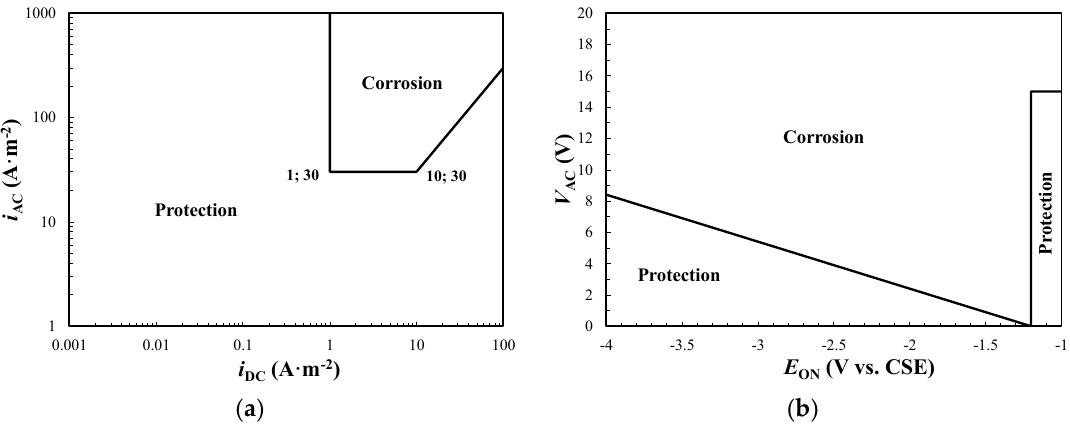
Figure 9. Graphical representation of the AC protection criteria reported on ISO 18086 [4]: ( a ) i AC vs. i DC , ( b ) V AC vs. E ON .